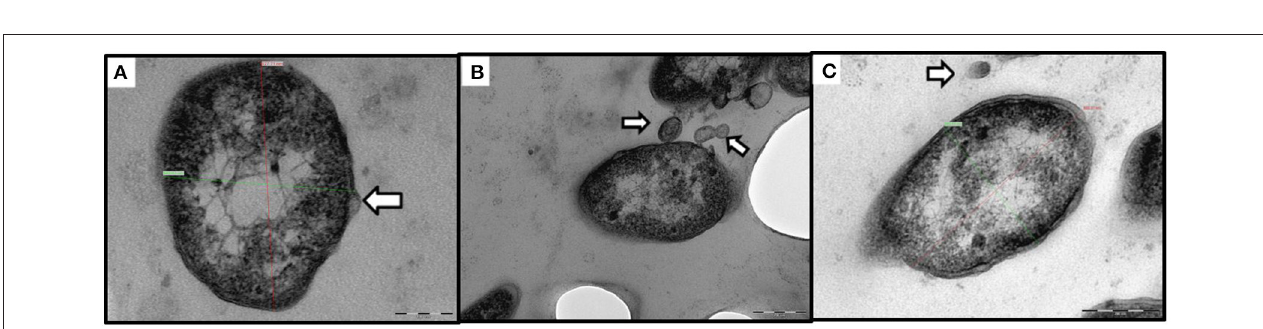
FIGURE 1 | Diagnostics of piscine francisellosis. (A) Diseased red Nile tilapia ( Oreochromis niloticus ). wn, white nodules in the enlarged spleen; pg, pale gills; al, atrophic liver. (B) Histopathological cross section of the spleen shown in (A), using haematoxylin and eosin stain. g, granulomas; cg, coalescence of granulomas (40x magnification). Inset: granuloma (200x magnification). (C) Transmission electron micrograph of Francisella -like cell. Cell size: 344.59nm (red line) × 264.23nm (green line), scale bar = 100nm. (D) Scanning electron micrograph showing several Francisella -like structures (orange) in the spleen.